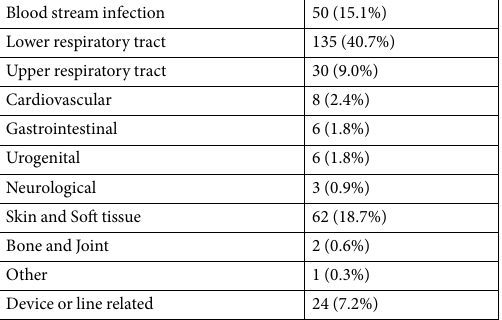
Table 2. SITES OF INFECTION – All infectious episodes (n = 332).